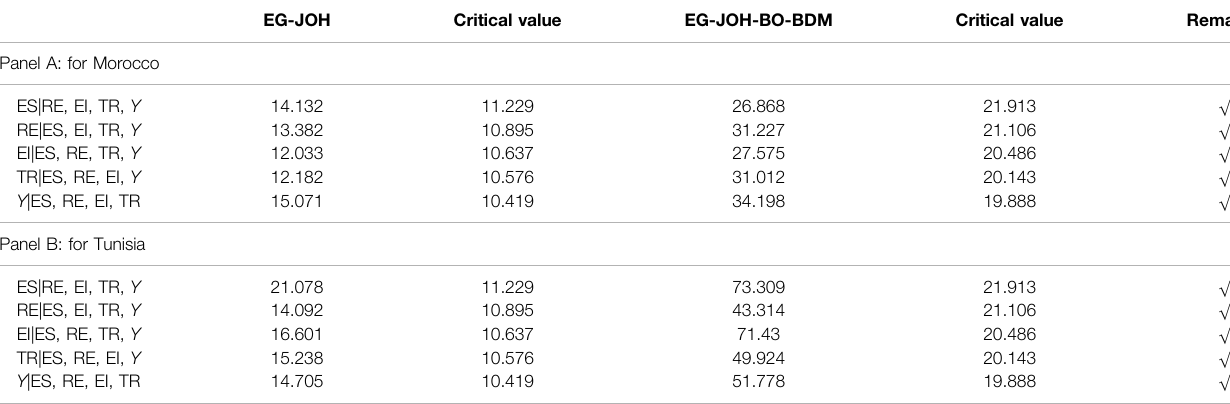
TABLE 6 | Results of combined cointegration test.